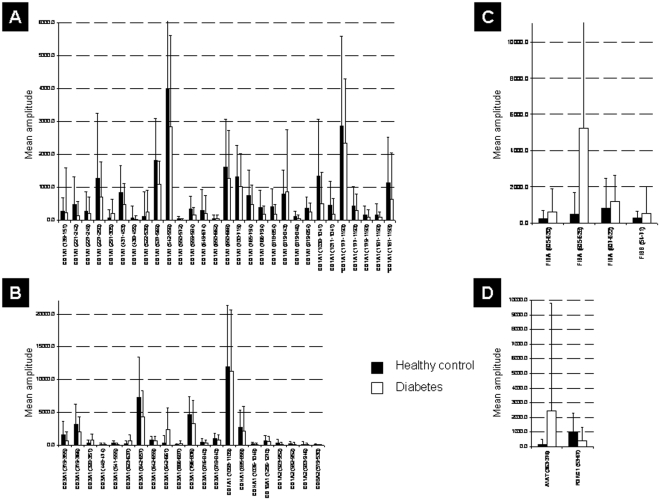
Regulation of diabetes peptide markers statistically significant in the multicenter validation set.Given are SwissProt accession names. (A) Regulation of collagen alpha 1 type I fragments. For two collagen fragments hydroxylated forms were identified (marked with asterisk *). (B) Regulation of others collagen fragments. (C) Regulation of fibrinogen alpha fragments. (D) Regulation of other identified peptide fragments.